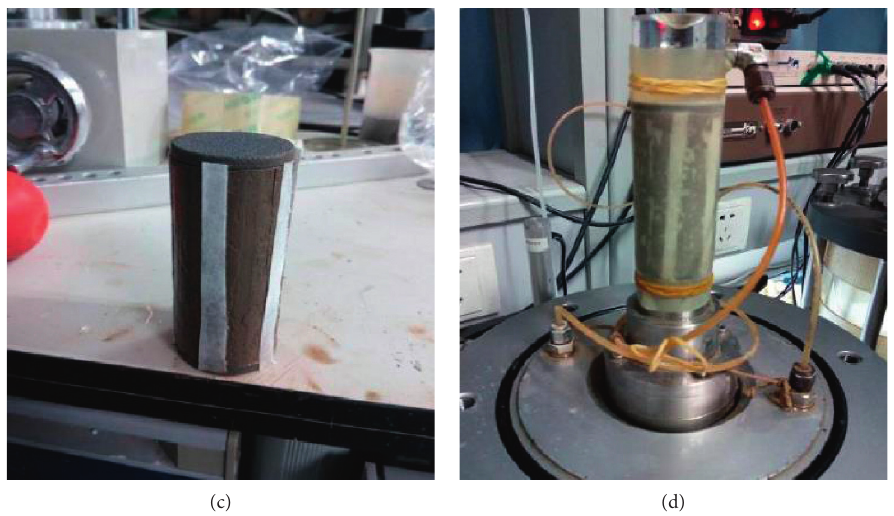
Figure 2: Sample preparation and installation process in triaxial shear tests. (a) Sample preparation. (b) Sample saturator. (c) Sample pasted with filter paper. (d) Sample